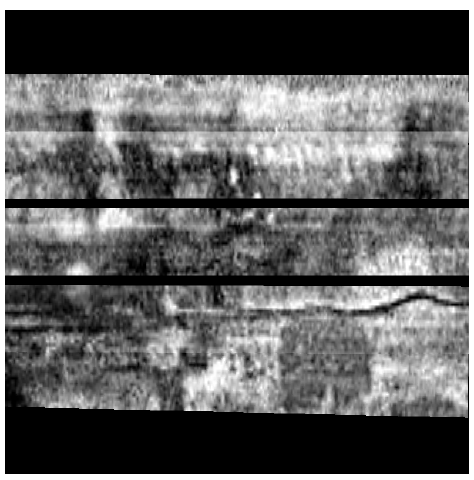
Figure 13. Crack images with blurry boundaries.